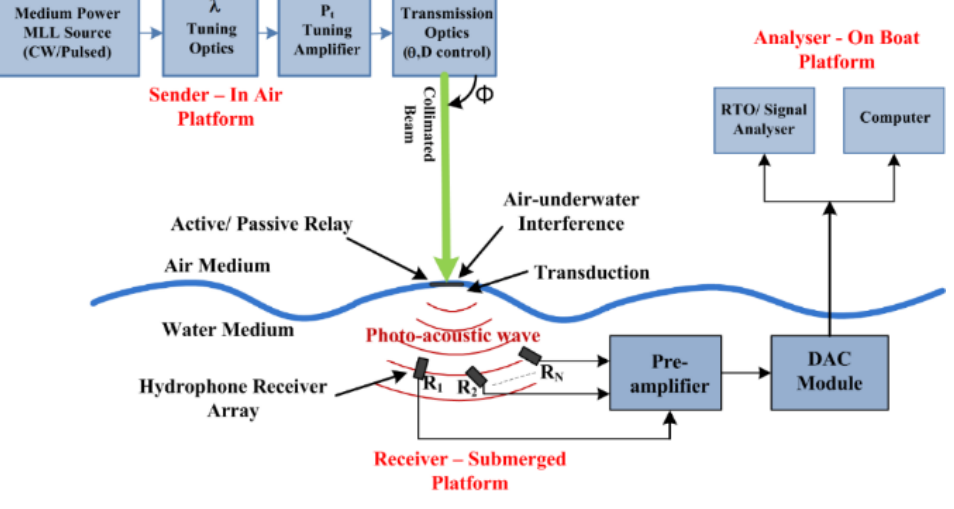
Figure 31. A top-level scheme for a PAC system and its performance